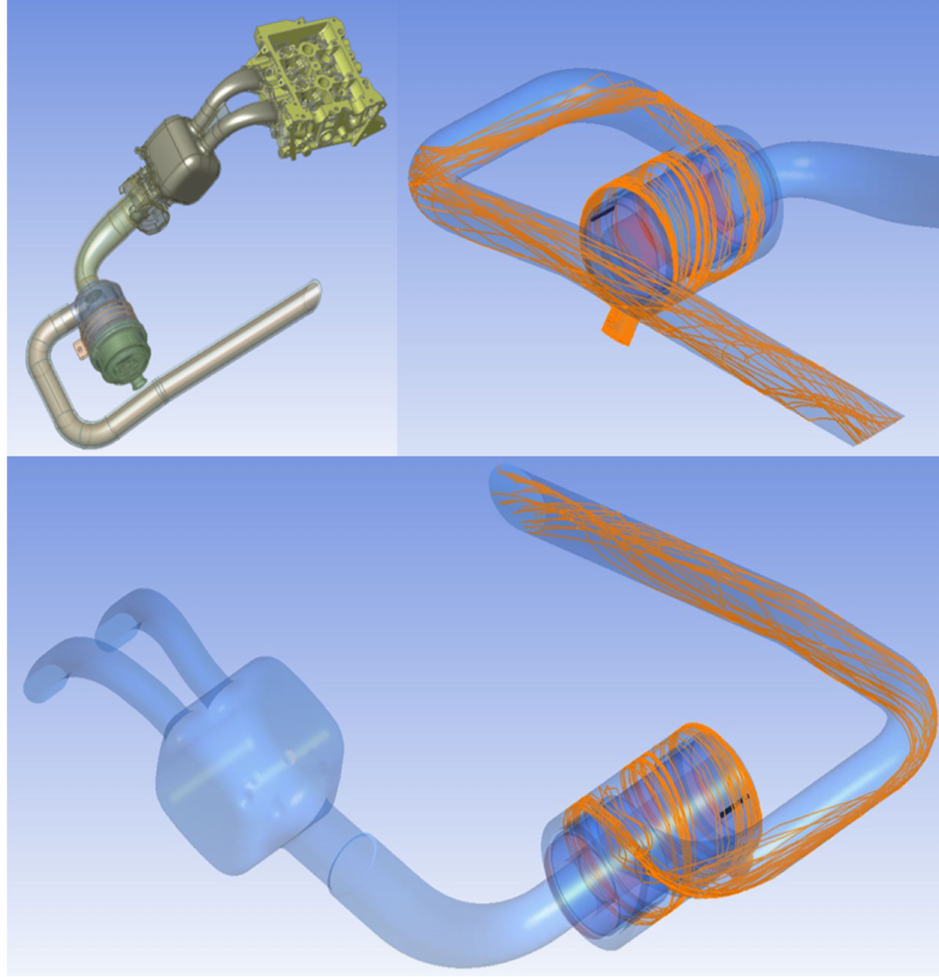
Figure 3. Air intake system configuration and traces of dust particles during